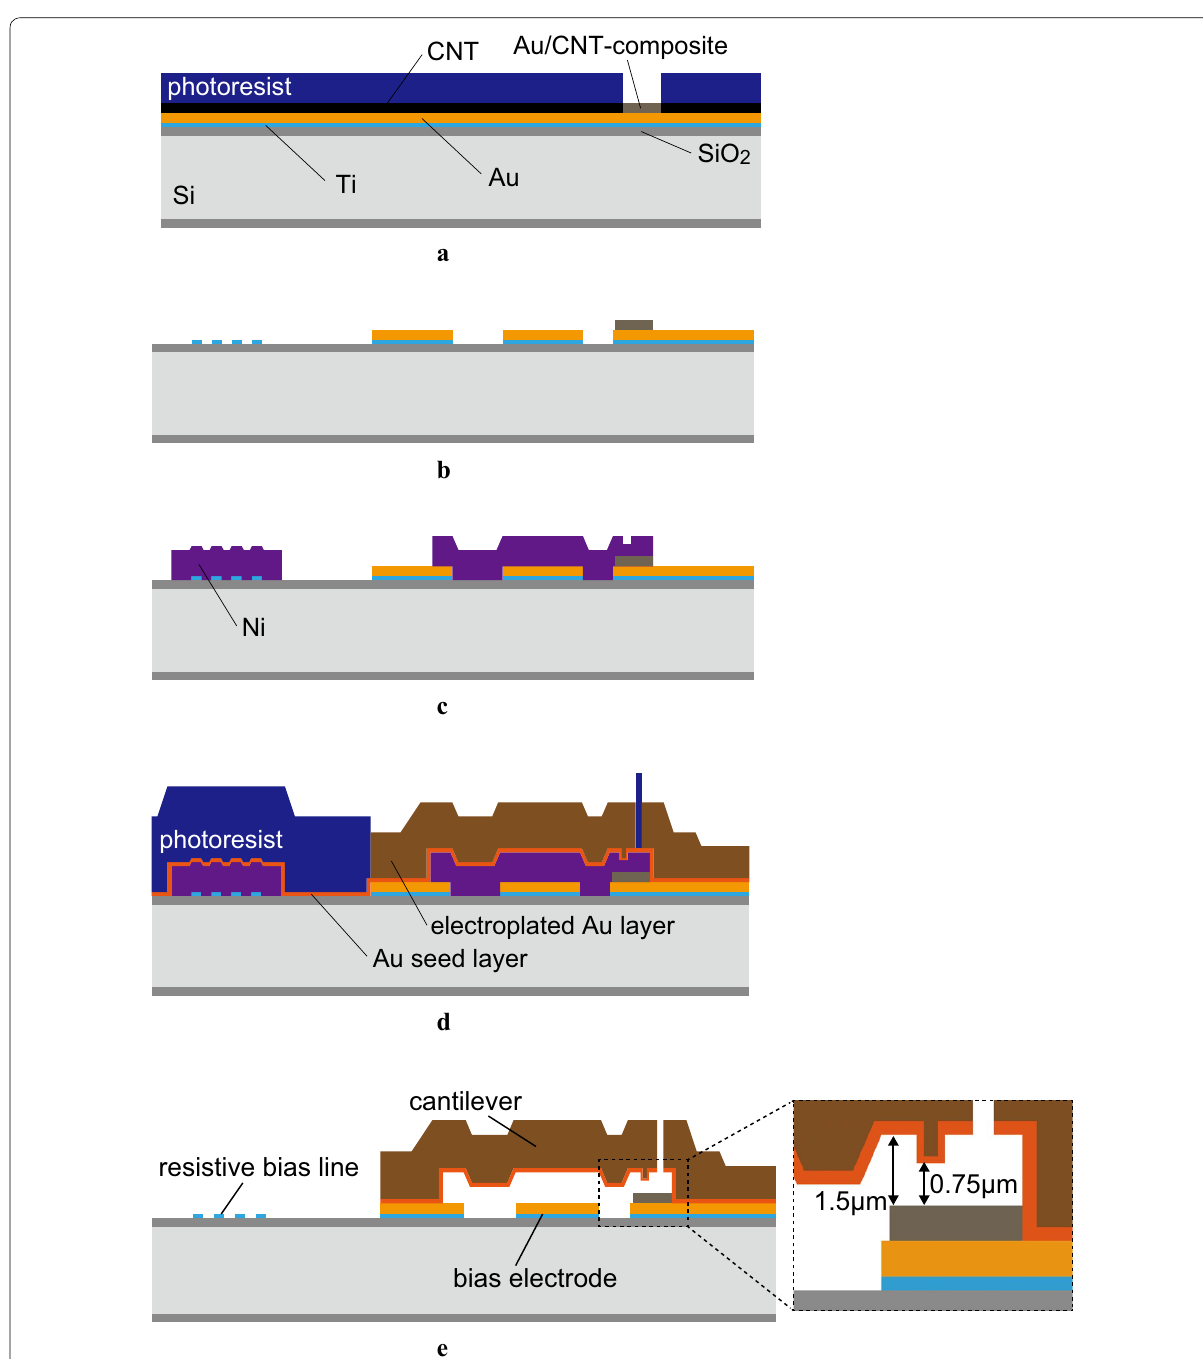
Fig. 3 Fabrication process of the RF‑MEMS switch with Au–Au/CNT‑composite